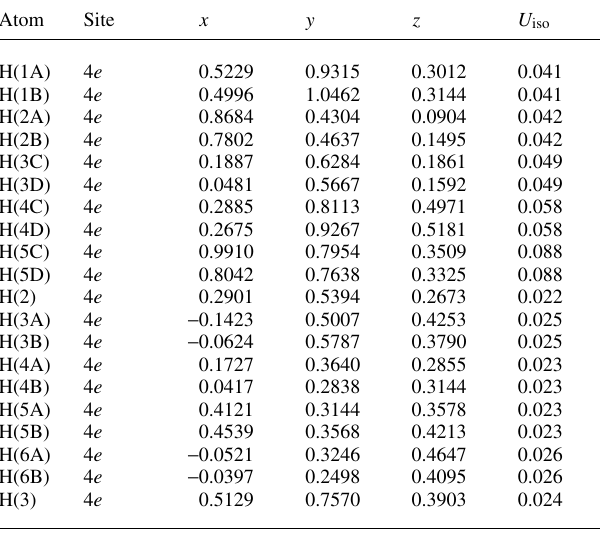
Table 2. Atomic coordinates and displacement parameters (in Å 2 )